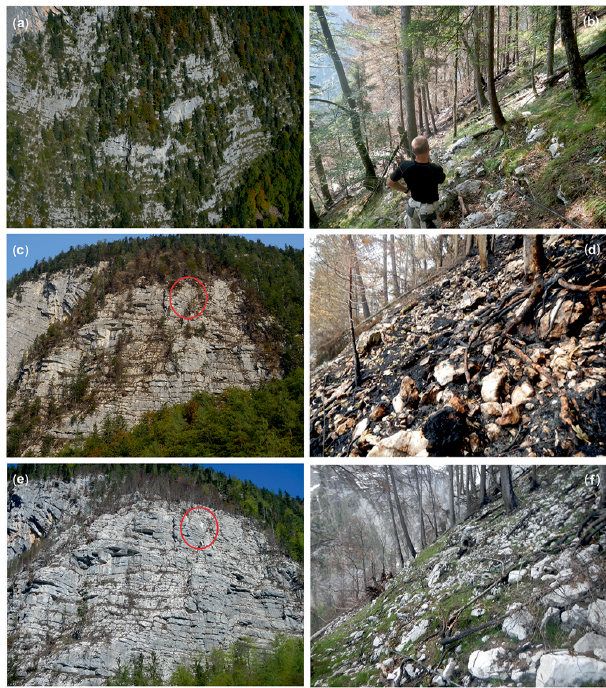
Figure 1. Temporal changes of the wildfire affected area: biomass, soil and rock characteristics before the wildfire in 2014 (a) , in the border between burned and not-burned forest in August 2018 (b) , directly after the wildfire in August 2018 (c, d) , and 8months after the burn in April 2019 (e, f) . Post-wildfire rockfalls (red circle in e ) with a volume of about a few cubic metres are